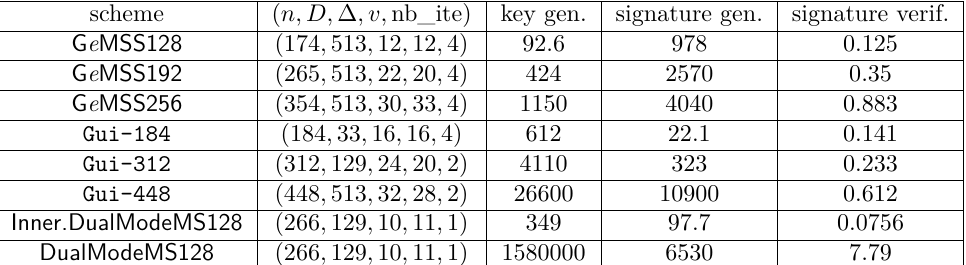
Table 28: Number of mega cycles for each cryptographic operation (best implementation provided for the NIST submissions). We use a Skylake processor (DesktopS). scheme key gen. signature gen. signature verif.